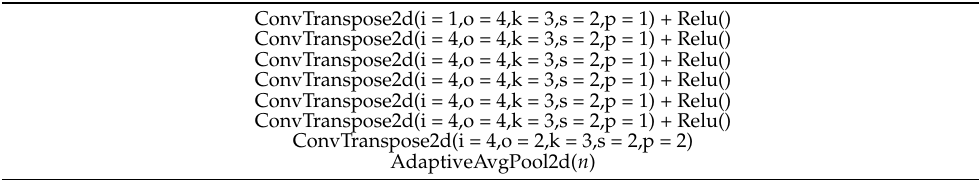
Table A2. HyperNN architecture parameters for anisotropic diffusion equation. Notations in Con-